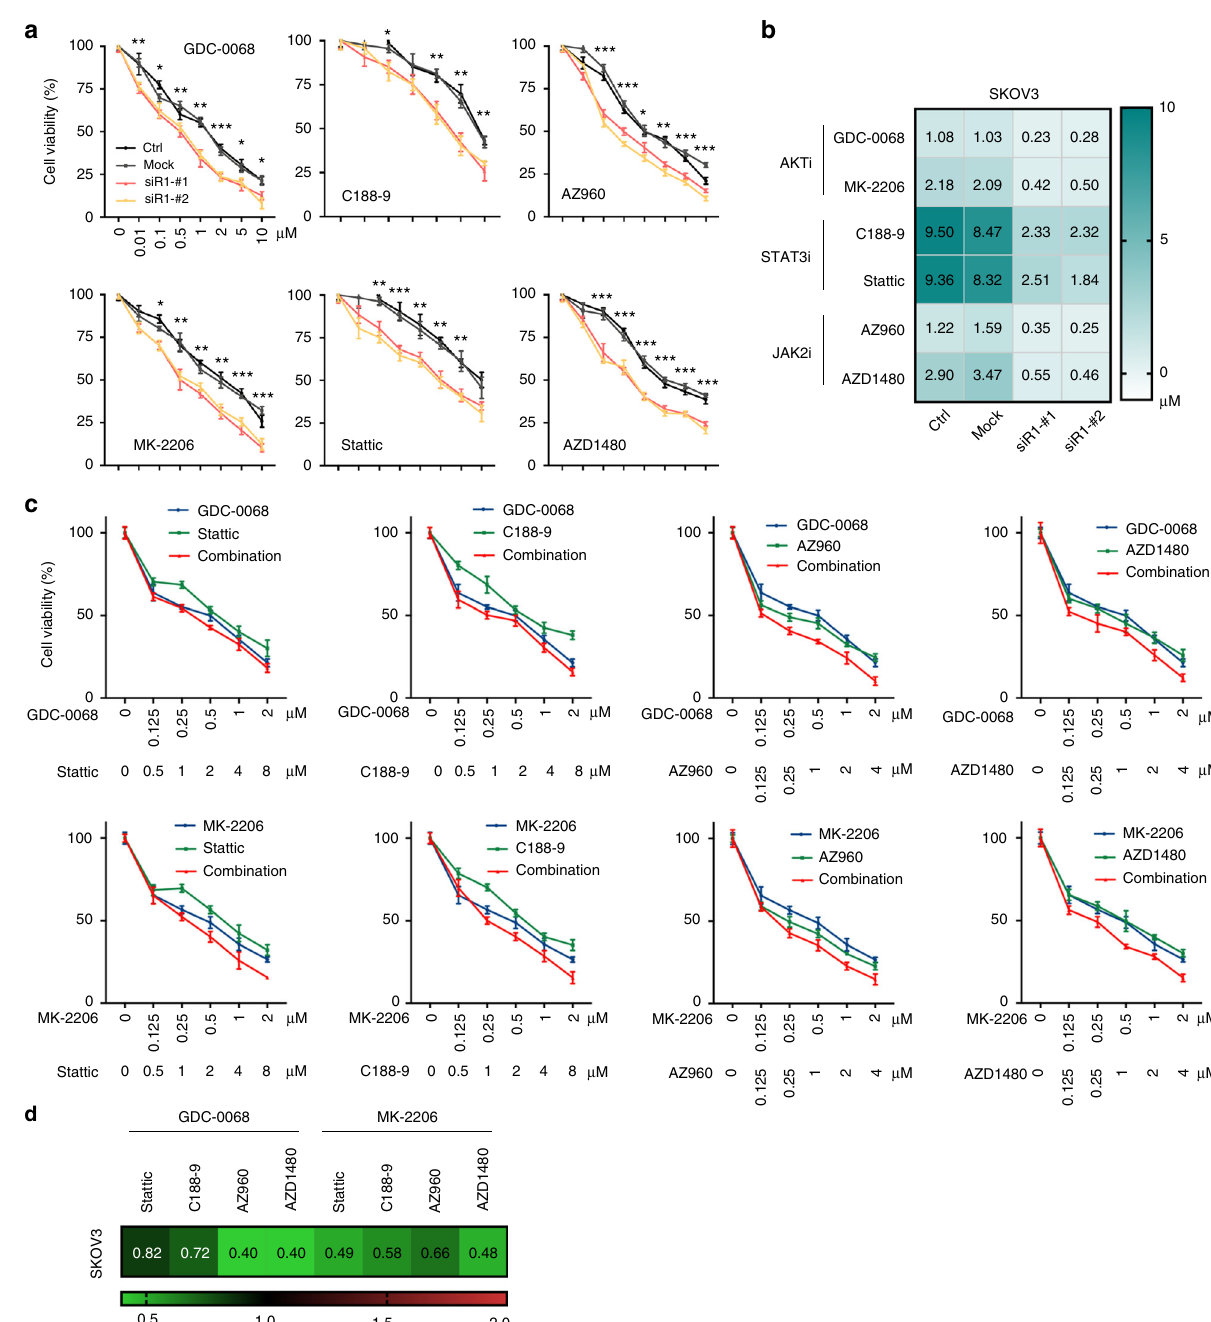
Fig. 7 PIK3R1 loss renders cells sensitive to JAK2, STAT3, and AKT inhibitors and co-targeting JAK2/STAT3 and AKT induces synergism. a SKOV3 cells of each inhibitor are shown. b IC50 values of each inhibitor were calculated by nonlinear regression analysis and are shown as heatmap. c SKOV3 3D spheroids were treated with each inhibitor alone or in combination as indicated, dose – response curves are shown. d Combination Index (CI) values were calculated with Chou-Talalay Method and CI values at the highest doses of the inhibitors used are visualized as heatmap. Error bars represent SD. * p < 0.05; ** p < 0.005; *** p < 0.001 compared with mock using t